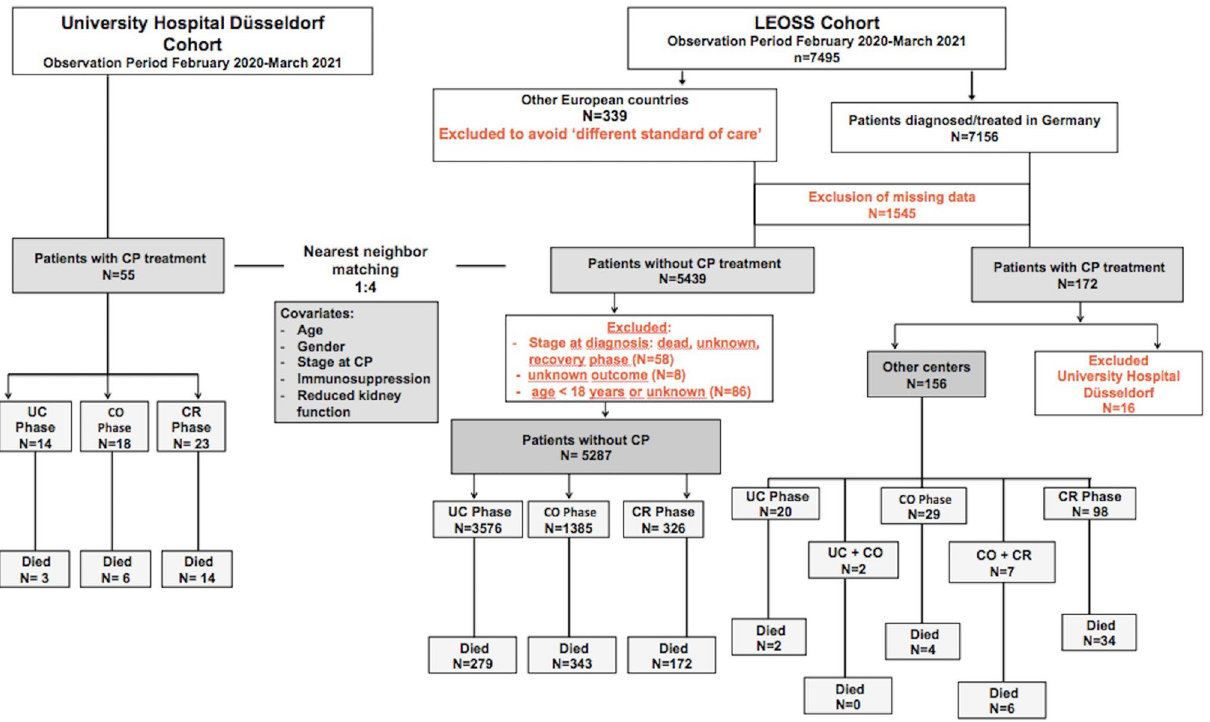
Figure 2. Study design and study population. N number, CP convalescent plasma, UC uncomplicated, CO complicated, CR